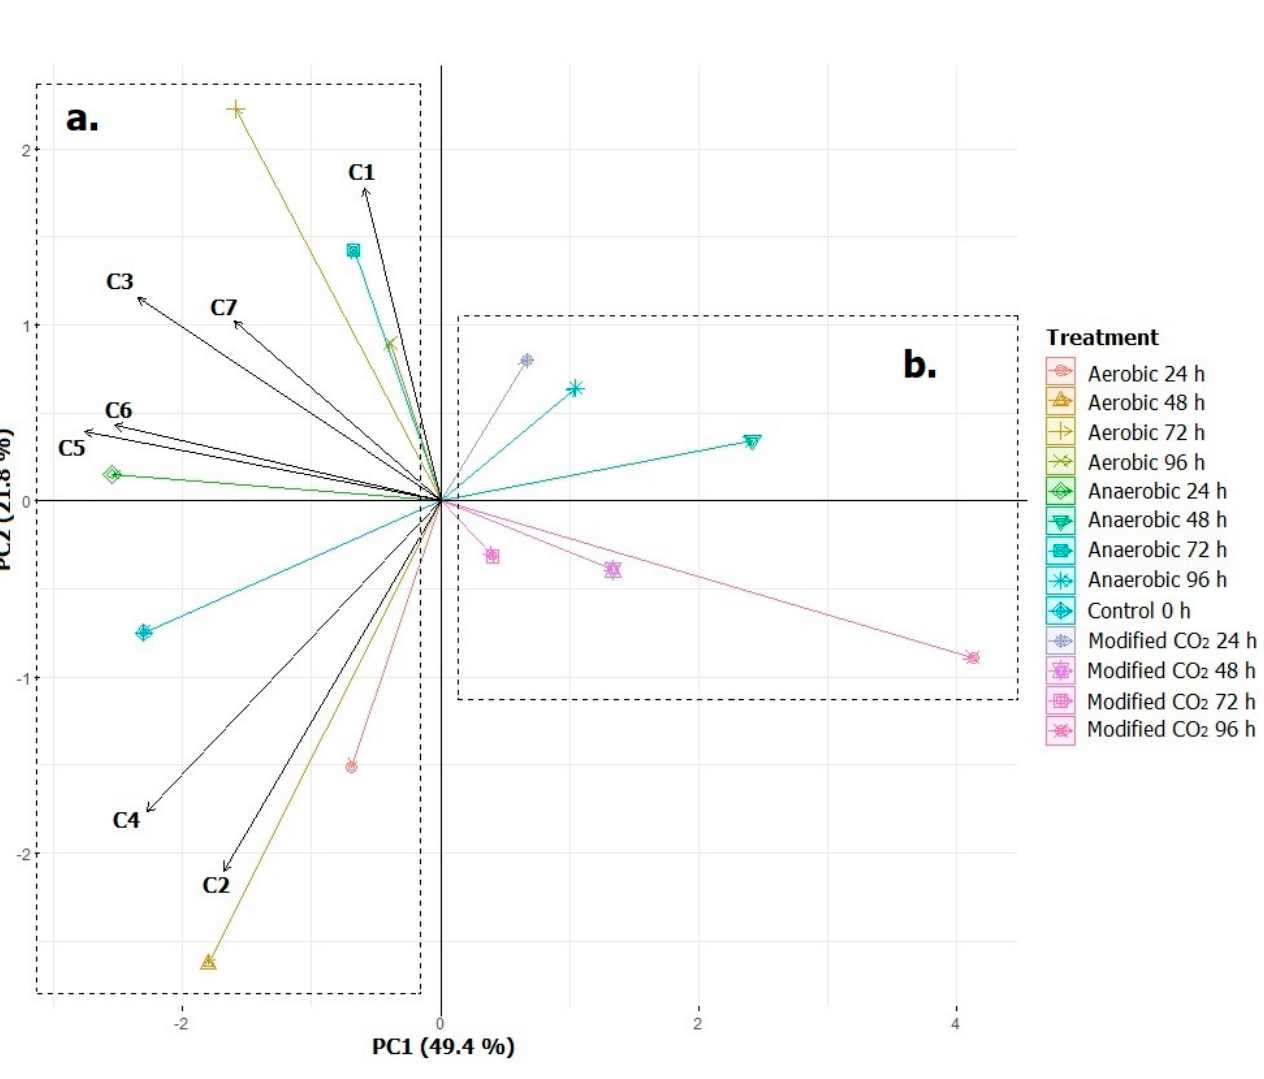
Figure 5. Principal component analysis of each treatment. C1: acetic acid. C2: 2-methylpyrazine. C3: 2-furancarboxaldehyde. C4: 2-furanmethanol. C5: 2,6-dimethylpyrazine. C6: 5-methylfurfural. C7: